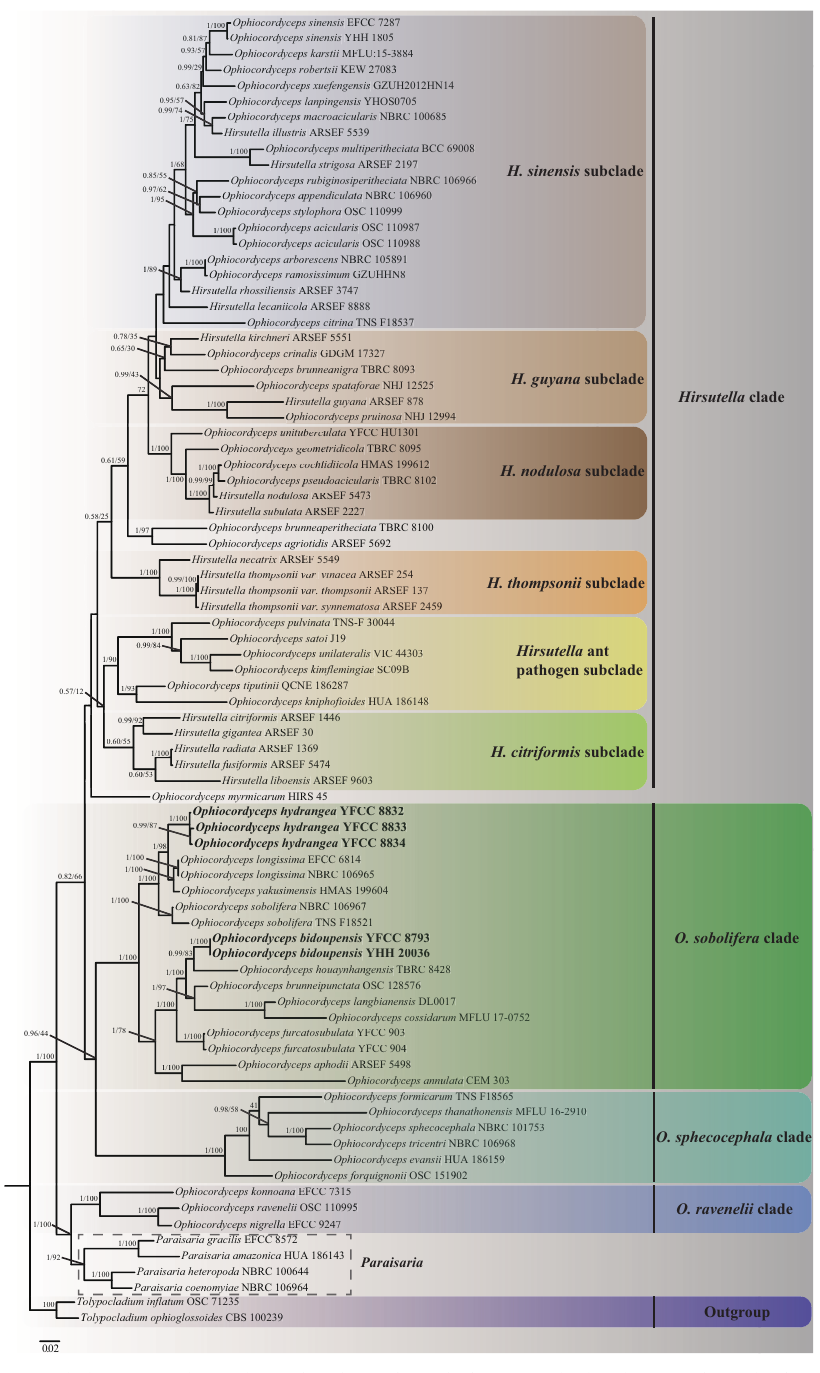
Figure 1. Phylogenetic relationships of Ophiocordyceps hydrangea and related species from the five genes dataset (nr LSU , nr SSU , tef-1 α , rpb1 , and rpb2 ) based on ML and BI analyses. Statistical support values of BI posterior probabilities and ML bootstrap proportions (0.5/≥50%) are shown at the